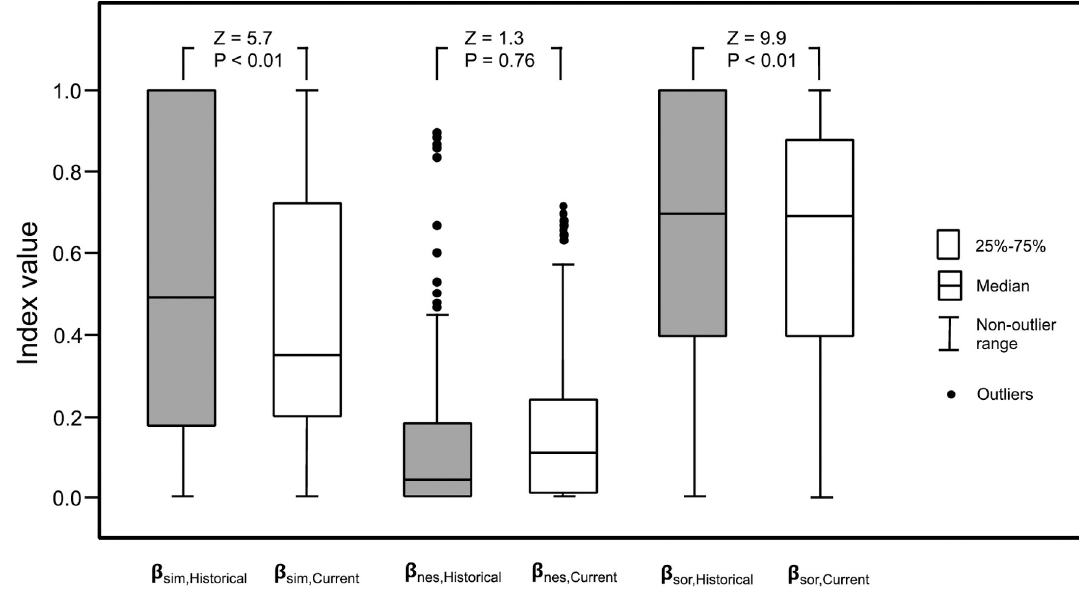
Fig 3. Box plot for distributions of turnover ( β sim,Historical , β sim,Current ), nestedness ( β nes,Historical , β nes,Current ) and β -diversity ( β sor, Historical , β sor,Current ) calculated for pairs among 29 basins. Distributions for these indices were compared considering historical and current freshwater fish assemblages.